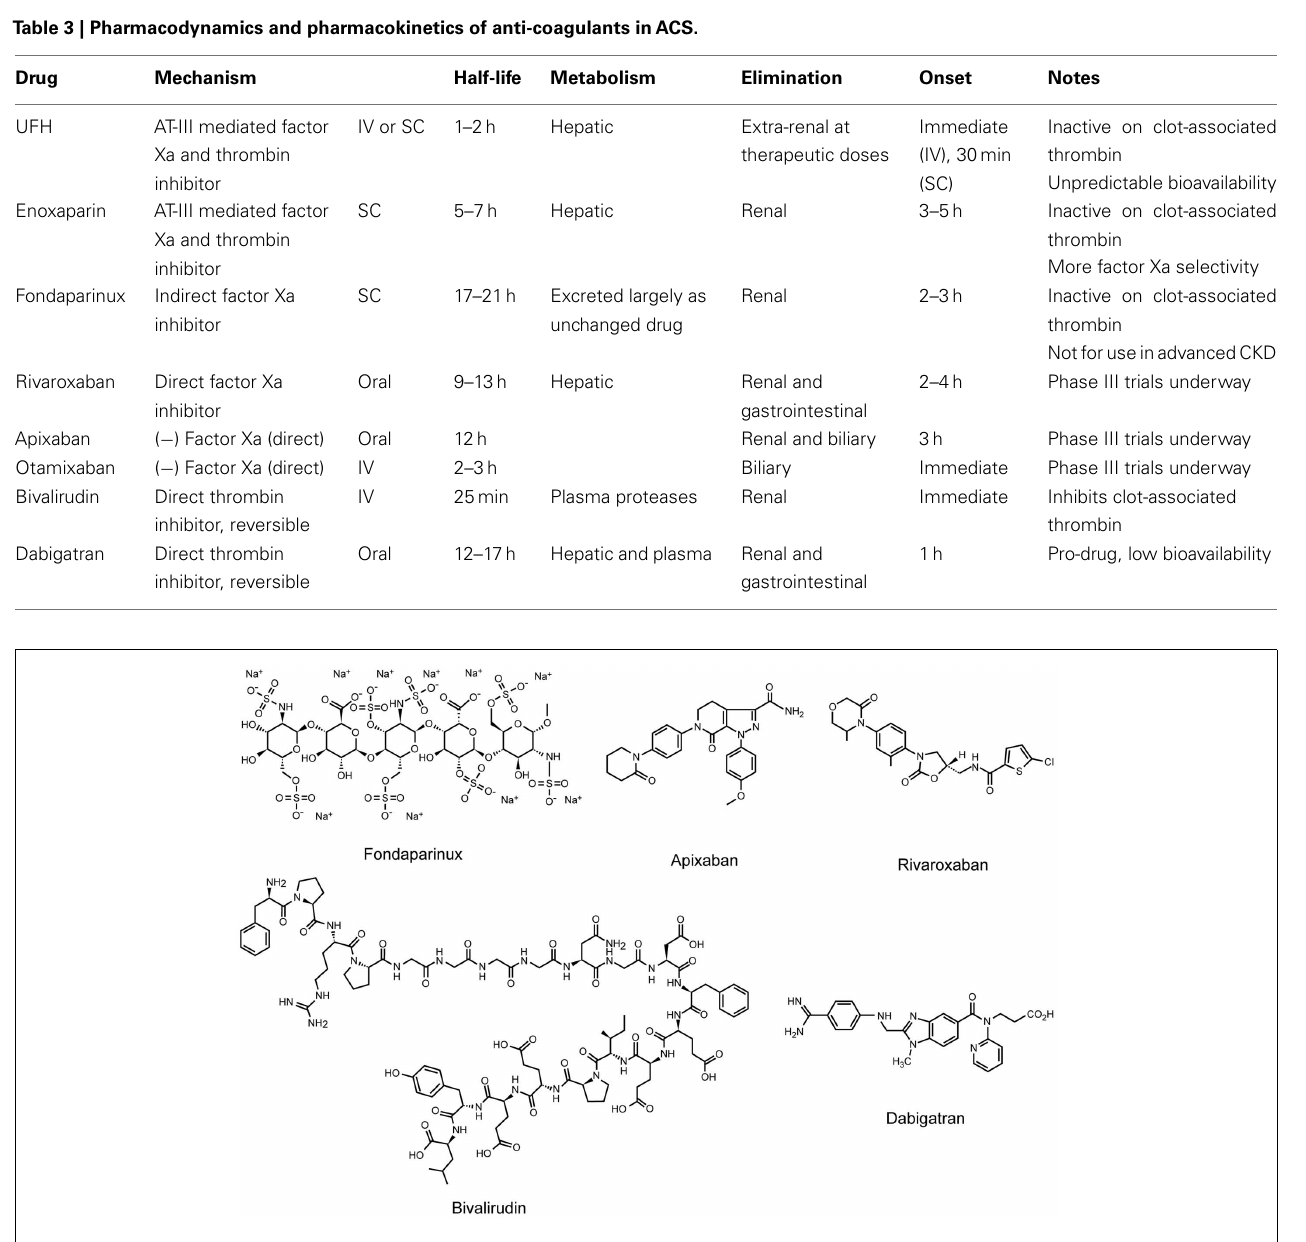
FIGURE 3 | Structure of factor Xa and direct thrombin